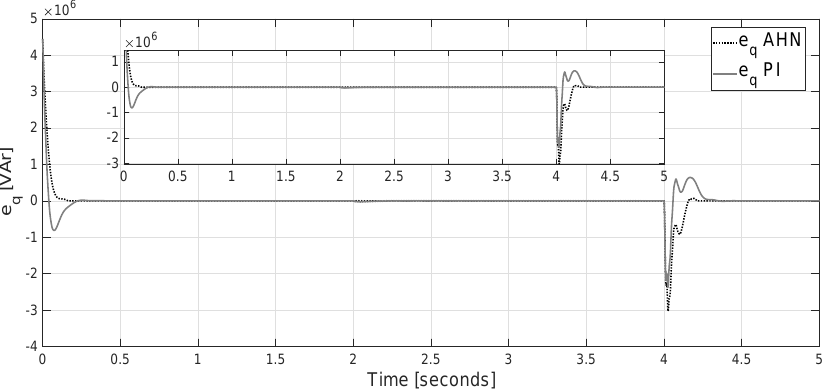
Figure 20. Simulation of the regulation error e q of reactive power during Test 3.